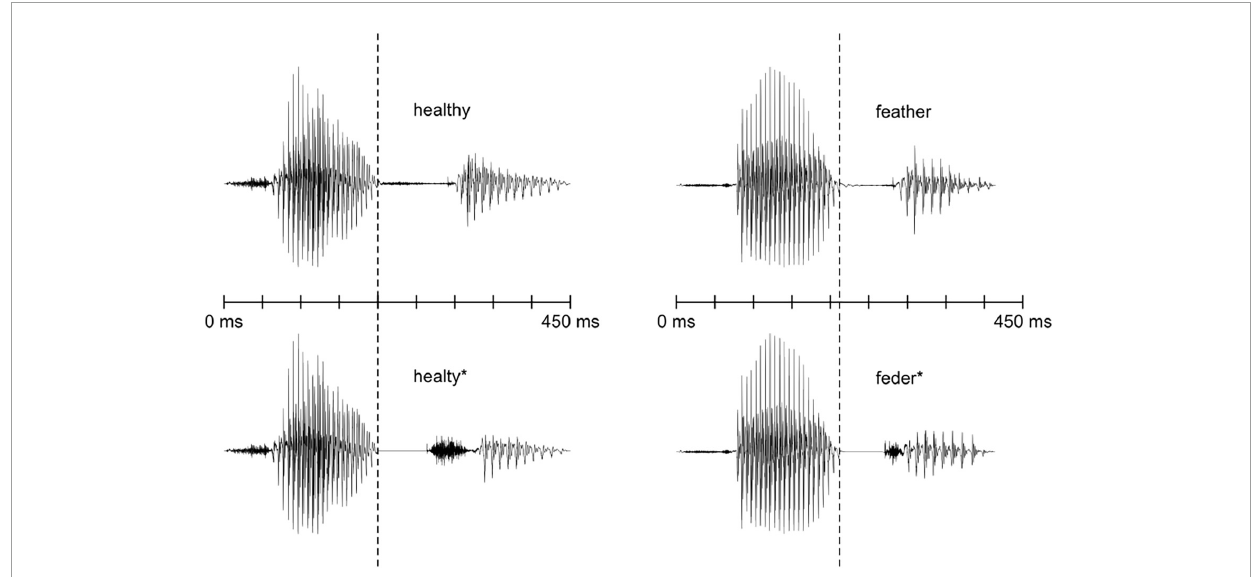
FIGURE1 Waveforms of the stimulus sounds. The time points where the pseudowords deviate from their word counterparts are marked with dashed lines.